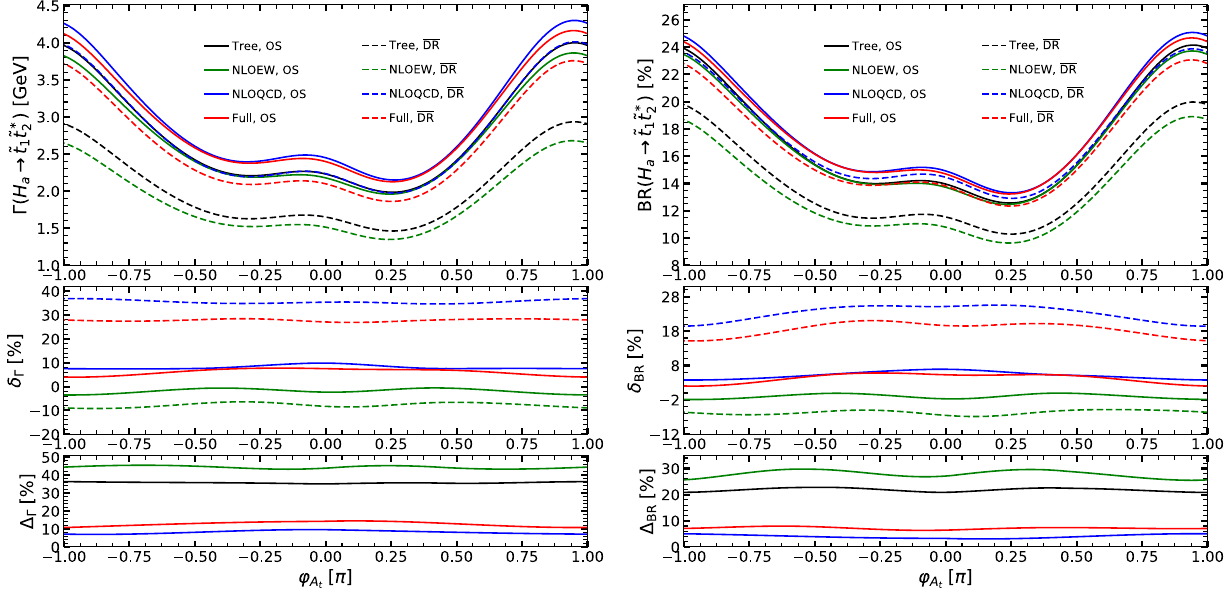
Fig. 12 Scenario2: Upper: Tree-level (black), NLO EW tions δ (see text, for definition) for the decay width (left) and branching (green), NLO QCD (blue) and full (red) partial width (left) and ratio (right) in the OS (full) and DR (dashed) scheme. Lower: branching ratio (right) of the decay H 4 ( = H a ) → ˜ t 1 ˜ t ∗ Relative differences (cid:20) between the OS and DR scheme (see text, as function 2 for definition) for the decay width (left) and branching . They are shown for the OS (full) and DR of the complex phase ϕ A t ratio (right) (dashed) scheme. Middle: Relative EW, QCD and EW+QCD correc-